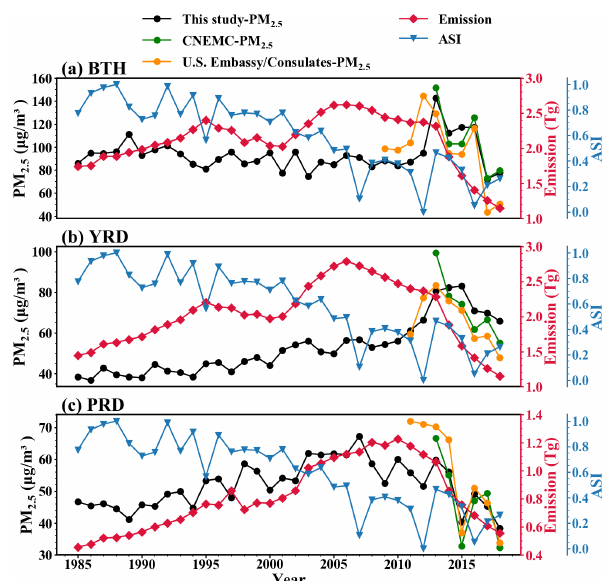
Figure 1. Annual winter averages of retrieved PM 2 . 5 concentra- tions (black, 1985–2018), emission (red, 1985–2018), and Arctic sea ice (ASI, blue, 1985–2018) in BTH, YRD, and PRD; PM 2 . 5 concentrations observed by the US Embassy and consulates in Bei- jing (orange, 2009–2018) and Shanghai and Guangzhou (orange, 2011–2018); PM 2 . 5 concentrations observed by CNEMC (green,